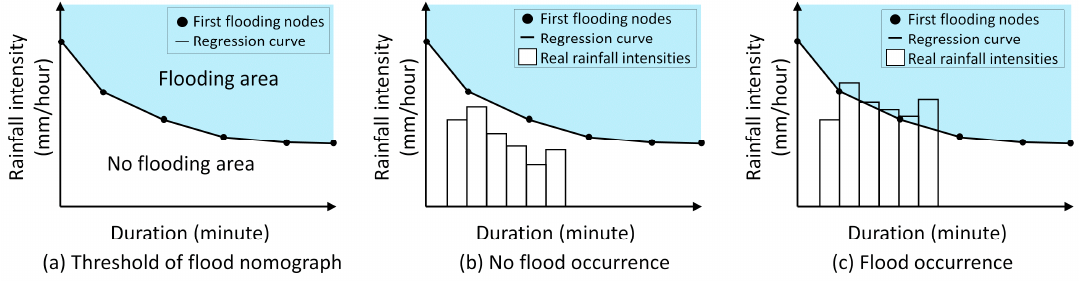
Figure 3. Schematic of flood forecasting via flood nomographs.